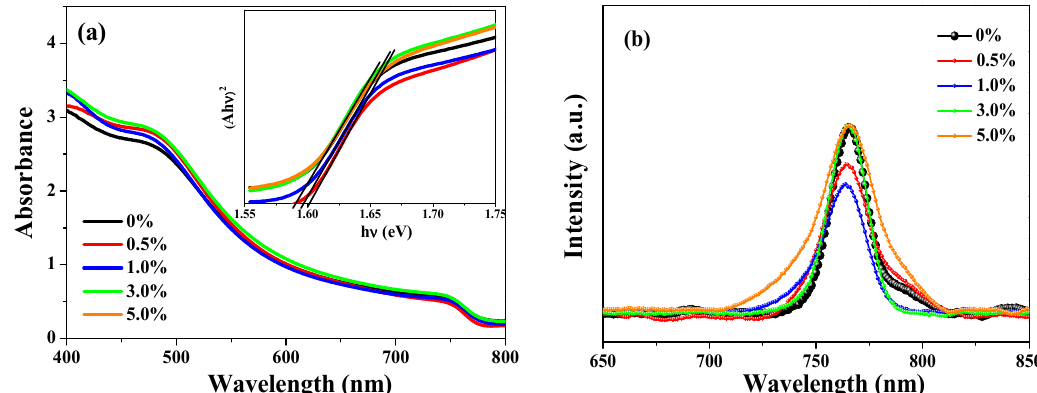
Figure 3. ( a ). The UV-visible absorption spectral of Ag-doped perovskite films, the insert image is Tauc plot curves; ( b ) Steady-state PL spectra of Ag-doped perovskite films deposited on spiro-OMeTAD.